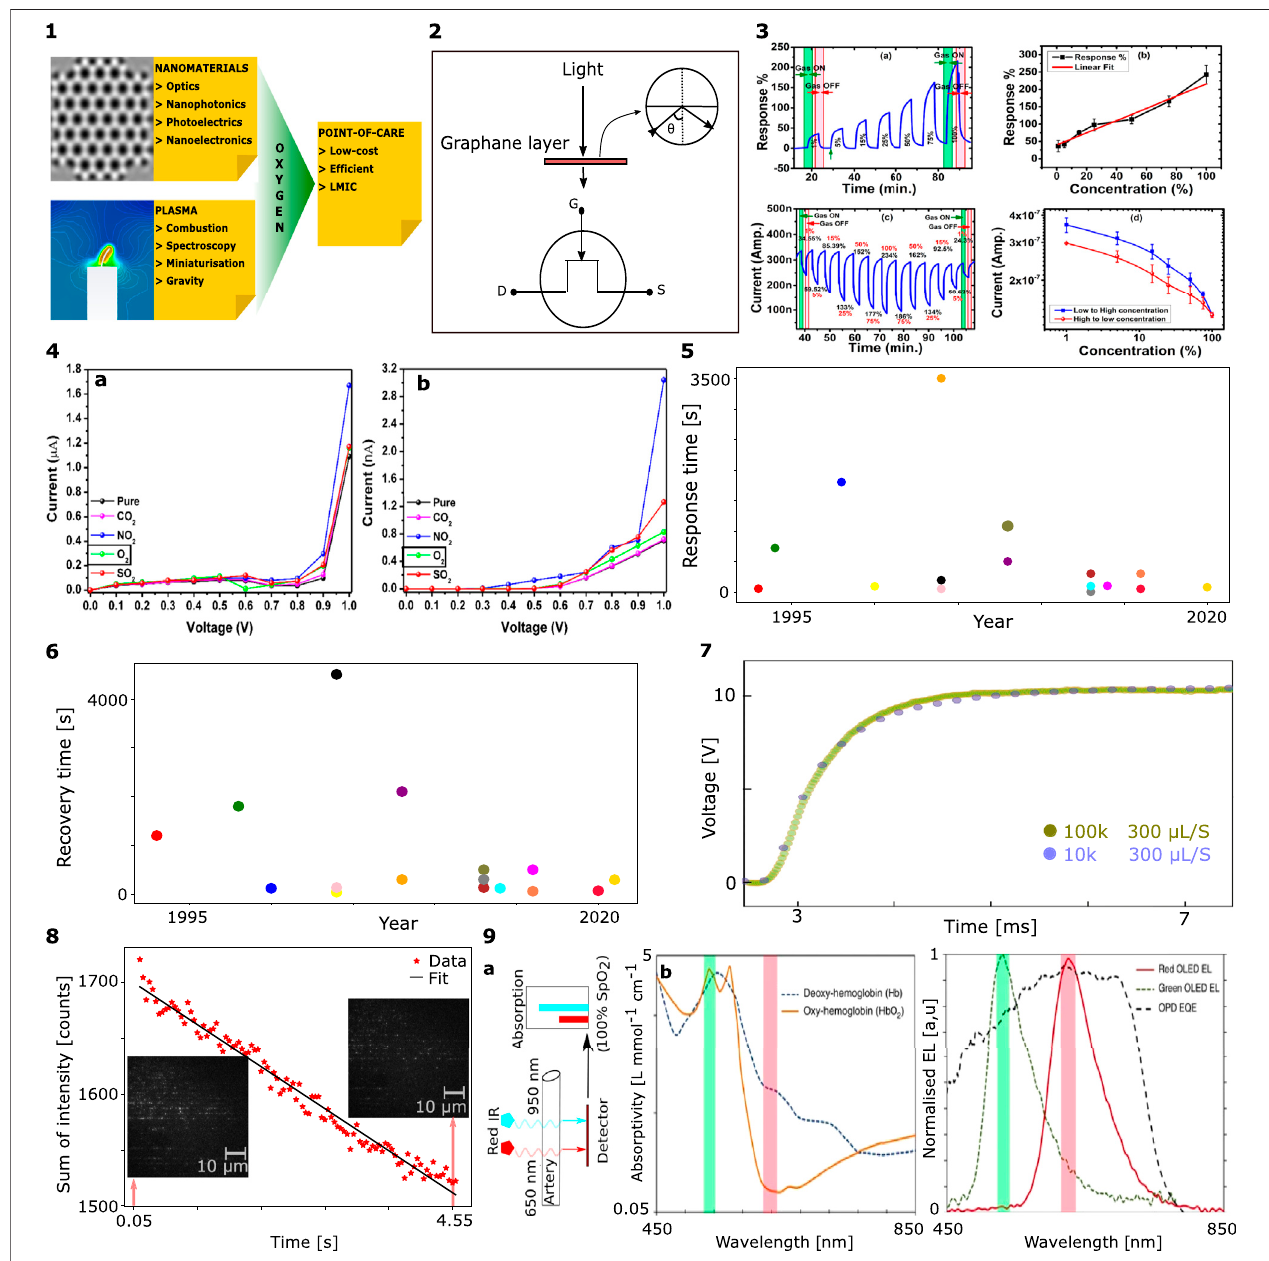
FIGURE 1 | (1) Overview of oxygen sensing with nanomaterials and plasma towards point of care (PoC). (2) Principle of graphene-based refractive index sensor. (3A) Response of TiS 2 nanomaterials over time with the presence and absence of oxygen gas. (3B) Linear response of TiS 2 nanomaterials with respect to the concentration of oxygen gas. Dynamic responseof sensor for oxygen and its linear fi t. (3C) Time-dependent current output from TiS 2 with the presence and absence of oxygengas. (3D) CurrentoutputfromTiS 2 withrespecttoconcentration ofoxygen[adapted fromSakhuja etal.(2020)]. (4A , 4B) Current – voltageresponseofSiBi foroxygenincontrasttoothergasesalongoneaxisandanotheraxis,respectively[adaptedfromKumaretal.(2021)]. (5) Ashbyplot — progressofmaterialresponsetime for oxygen sensor over the period of 1990 and 2020. (6) Ashby plot — progress of material recovery time of nanomaterial-based oxygen sensor with respect to year of published papers. (7) Comparison ofreal-timevoltage curve ofGRIS at collection frequencies of10 and 100 kHz [adapted from Xing et al.(2012)]. (8) Photooxidation of singleAtto-488 fl uorphoresinsidenano fl uidicdevice(insetscalebars = 10 μ m). (9A) Principleofpulseoximetrysensorwithtwowavelengthsoflight. (9B) Absorptivityof oxygenated (orange solid line) and deoxygenated (blue dashed line) hemoglobin in arterial blood as a function of wavelength [adapted from Lochner et al. (2014)].